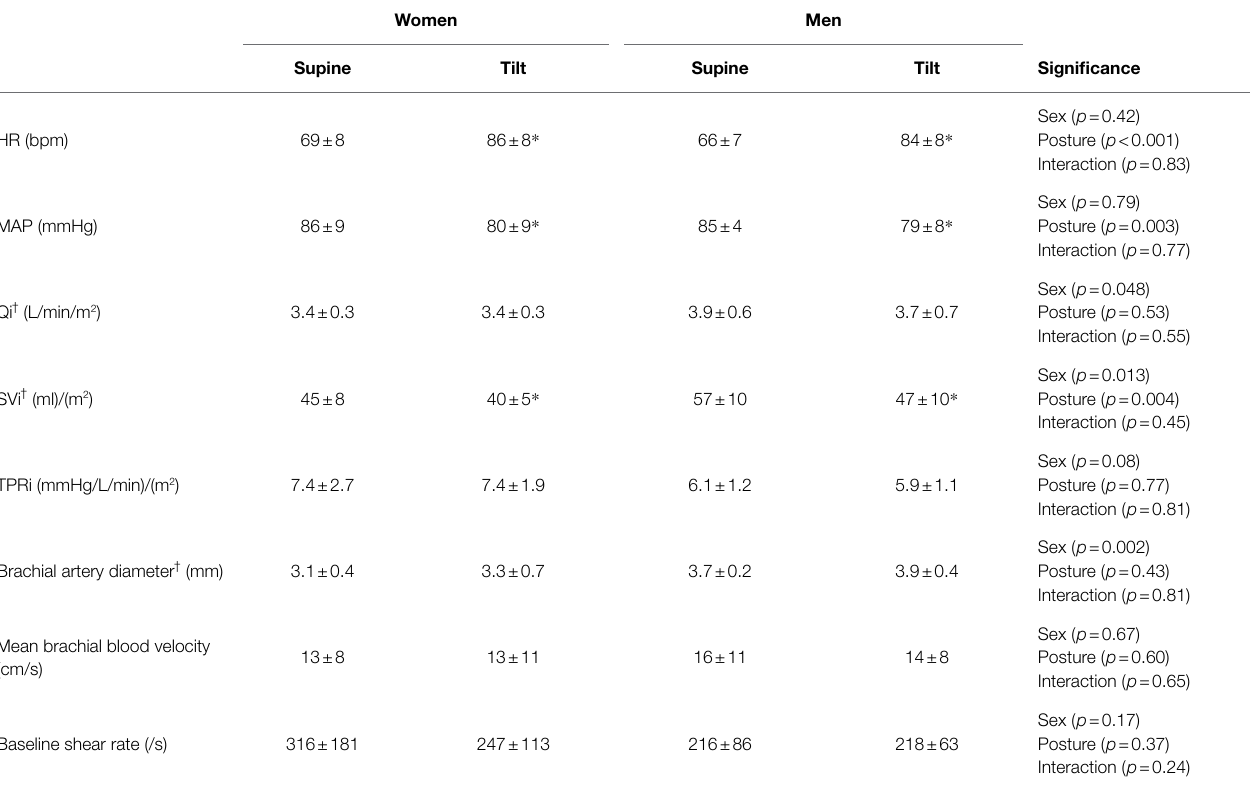
TABLE 2 | Baseline hemodynamics and brachial artery diameter of women and men prior to starting the FMD protocol in the supine and tilt